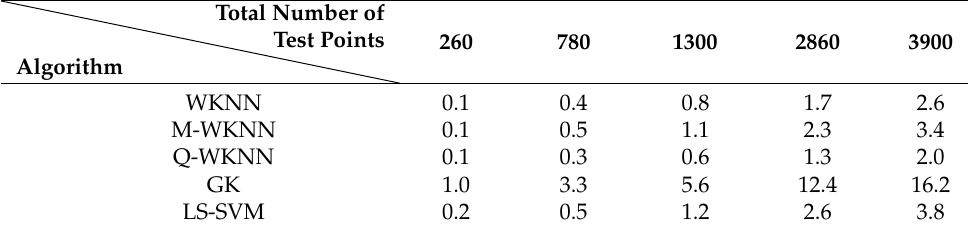
Table 5. Time consumption for algorithms based on different test sample sizes on